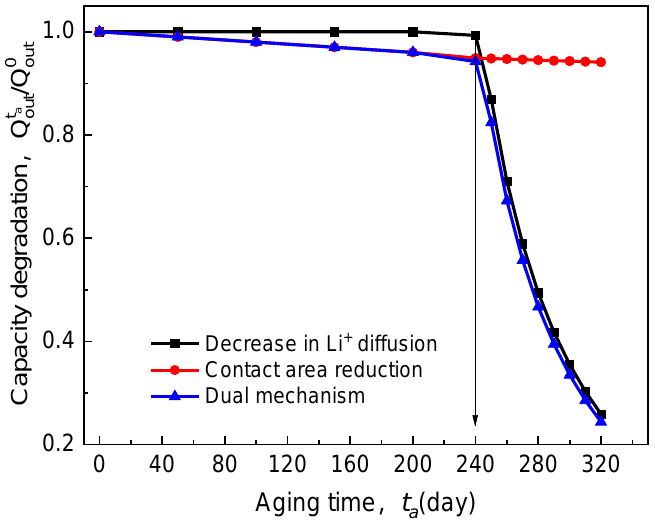
Figure 6. Effect of electrolyte time-aging on discharge capacity degradation.